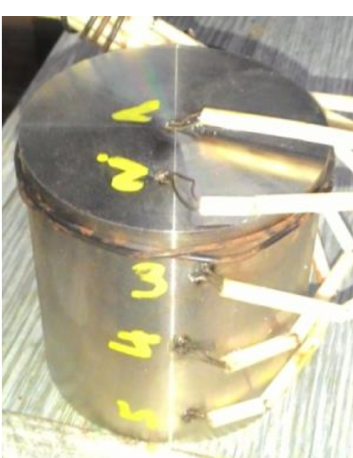
Figure 12. Temperature measurement setup.